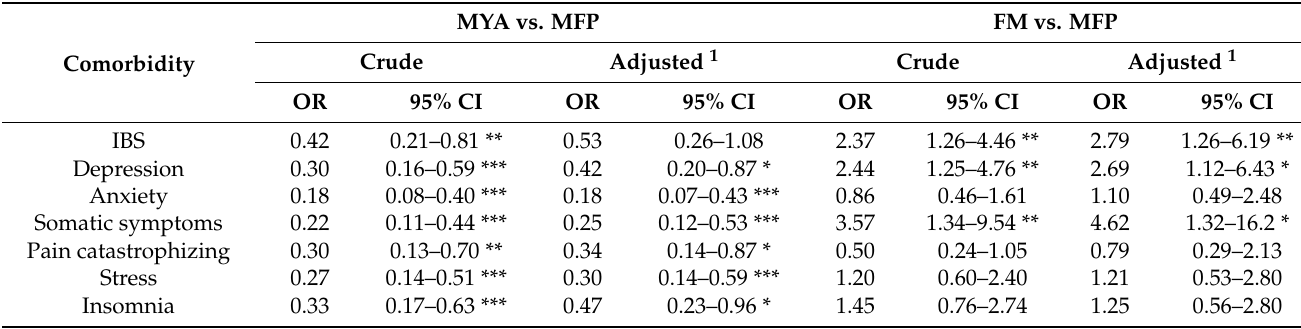
Table 3. Multinomial logistic regression analyses assessing the association between each specific comorbidity and the pain groups (dependent variable). In these analyses, individuals with MFP were set as a reference against which the other groups were compared.